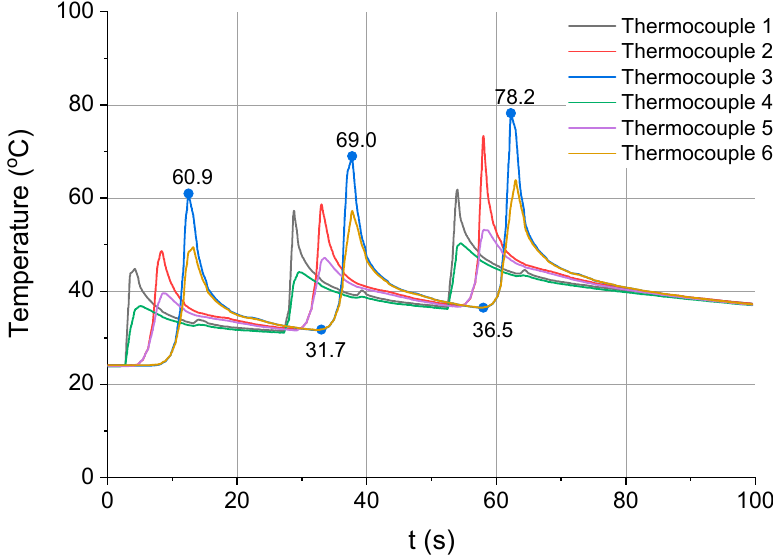
Figure 11. Temperature vs. time for the third milling strategy (three passes of the tool with ap = 1 mm).